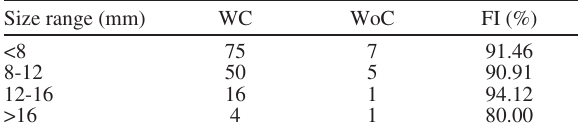
Table 3. – Size variation of the feeding incidence (FI) of clingfish Sicyases sanguineus from central Chile. WC, with content; WoC, without content.